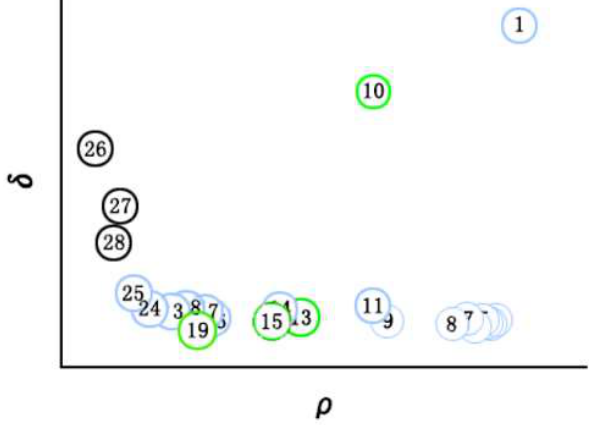
Figure 1. Decision Diagram Example.